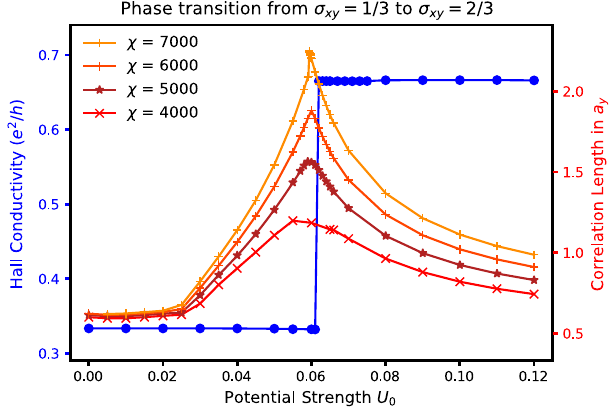
FIG. 4. The DMRG simulation result of the electrons on the infinite cylinder with circumference size L y ¼ 31 . 9 l B . We con- sider the LLL under a square lattice potential [Eq. (8)] with V V 1 , V V 1 . 4 , magnetic flux density (per unit 1 ¼ 2 ¼ 3 ¼ 4 ¼ cell) ϕ ¼ 2 , electron density n ¼ 2 = 3 . We change the strength of lattice potential U 0 with a step size Δ U ¼ 0 . 001 , with the strength of the short-ranged Coulomb interaction being constant, E 1 . The blue line represents the change of Hall conductivity, C ¼ which is measured at bond dimension χ ¼ 2000 . It shows a sharp direct transition between the σ xy ¼ 1 = 3 and σ xy ¼ 2 = 3 state at U ∼ 0 . 06 . Red lines represent the change of correlation length 0 (in the unit of lattice constant a in the y -direction) with different bond dimensions χ . At the phase transition point ( U 0 ∼ 0 . 06 ), the correlation seems to diverge with the bond dimensions. The < 10 − 6 at U 0 , ϵ ∼ 6 × 10 − 5 at the truncation error is ϵ 0 ¼ trun trun ∼ 4 × 10 − 5 at the σ 2 = 3 critical point, and ϵ xy ¼ trun